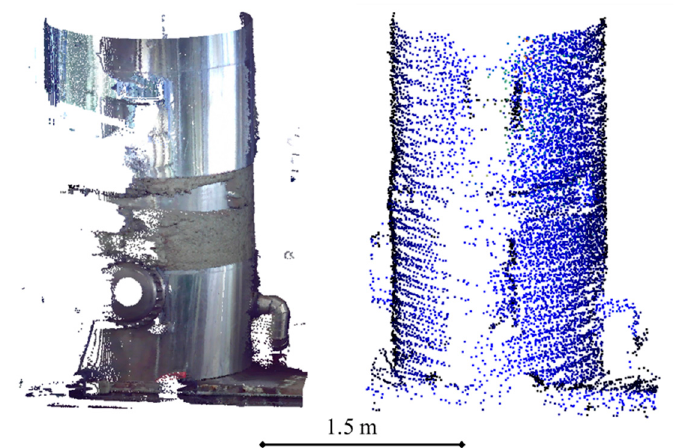
Figure 11. Example of points clouds of the burner system located in the boilers obtained with Faro (Left) and with Zeb-Revo (Right).